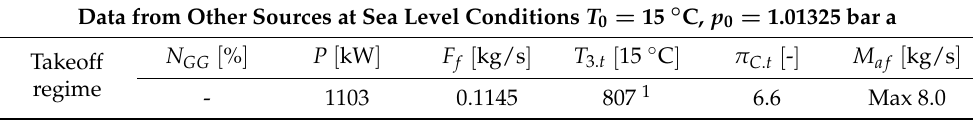
Table 5. Engine data for takeoff regime, based on outside sources.